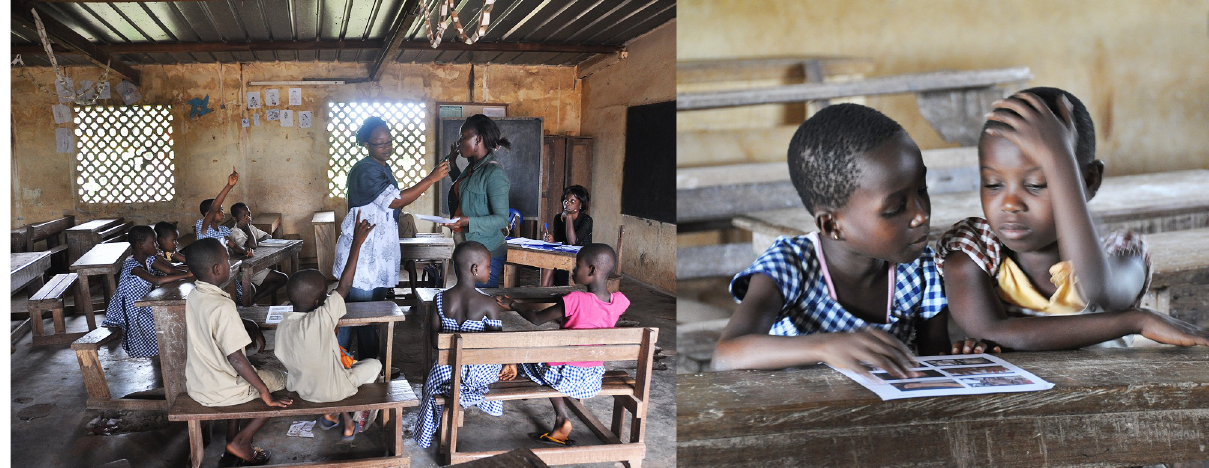
Fig 1. Scene of focus group discussion with